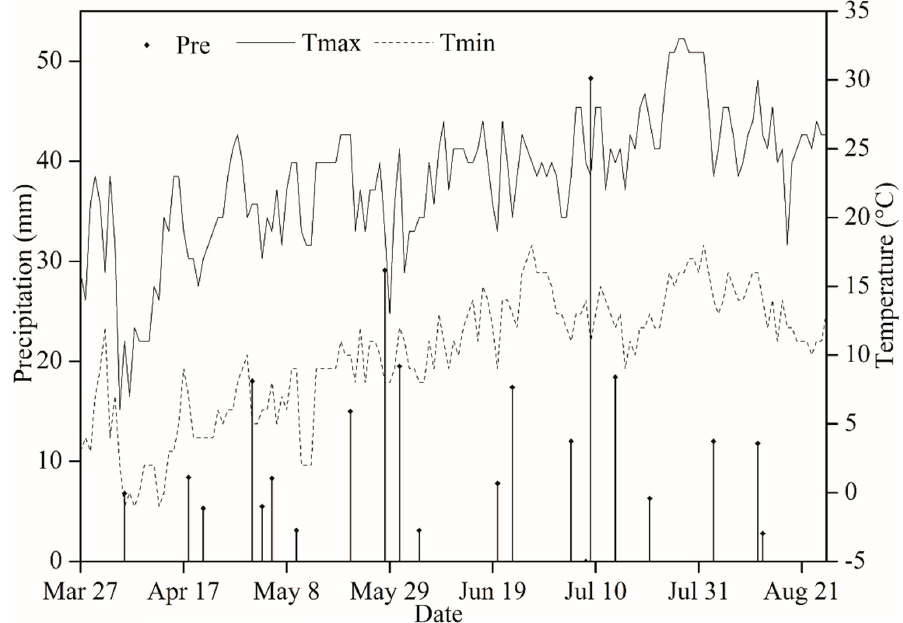
Figure 1. Daily precipitation (vertical drop lines) and maximum (solid lines) and minimum (dotted lines) air temperature during the growing season of spring wheat in 2015.